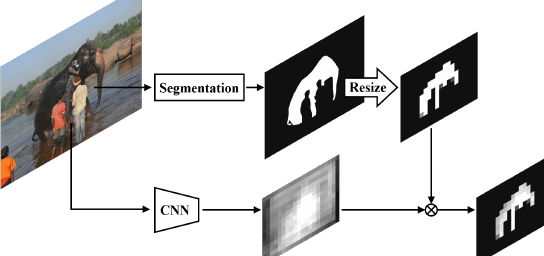
Figure 4. An overview of the convolutional feature masking (CFM) approach for feature extraction. The image is fed to the segmentation model to obtain masks and fed to the CNN to obtain feature maps, respectively. The masks are resized to have the same size as the feature maps. The feature maps are then multiplied by the resized mask to obtain the segmentation-region